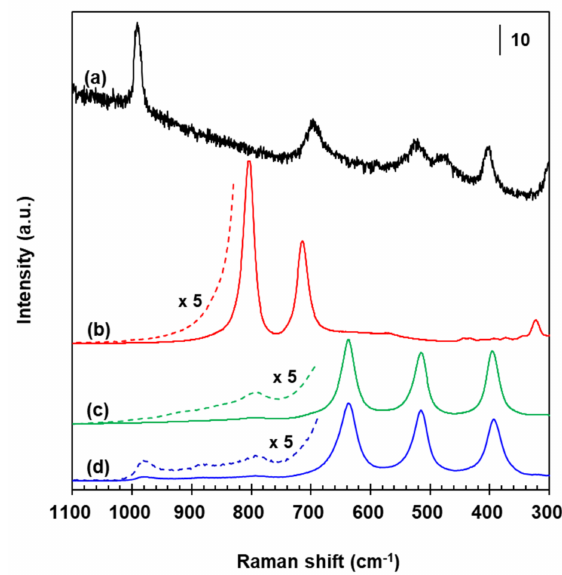
Figure 7. Raman spectra for reference chemicals and a supported WO 3 -only sample: ( a ) V 2 O 5 ; ( b ) WO 3 ; ( c ) TiO 2 ; ( d ) 10% WO 3 /TiO 2